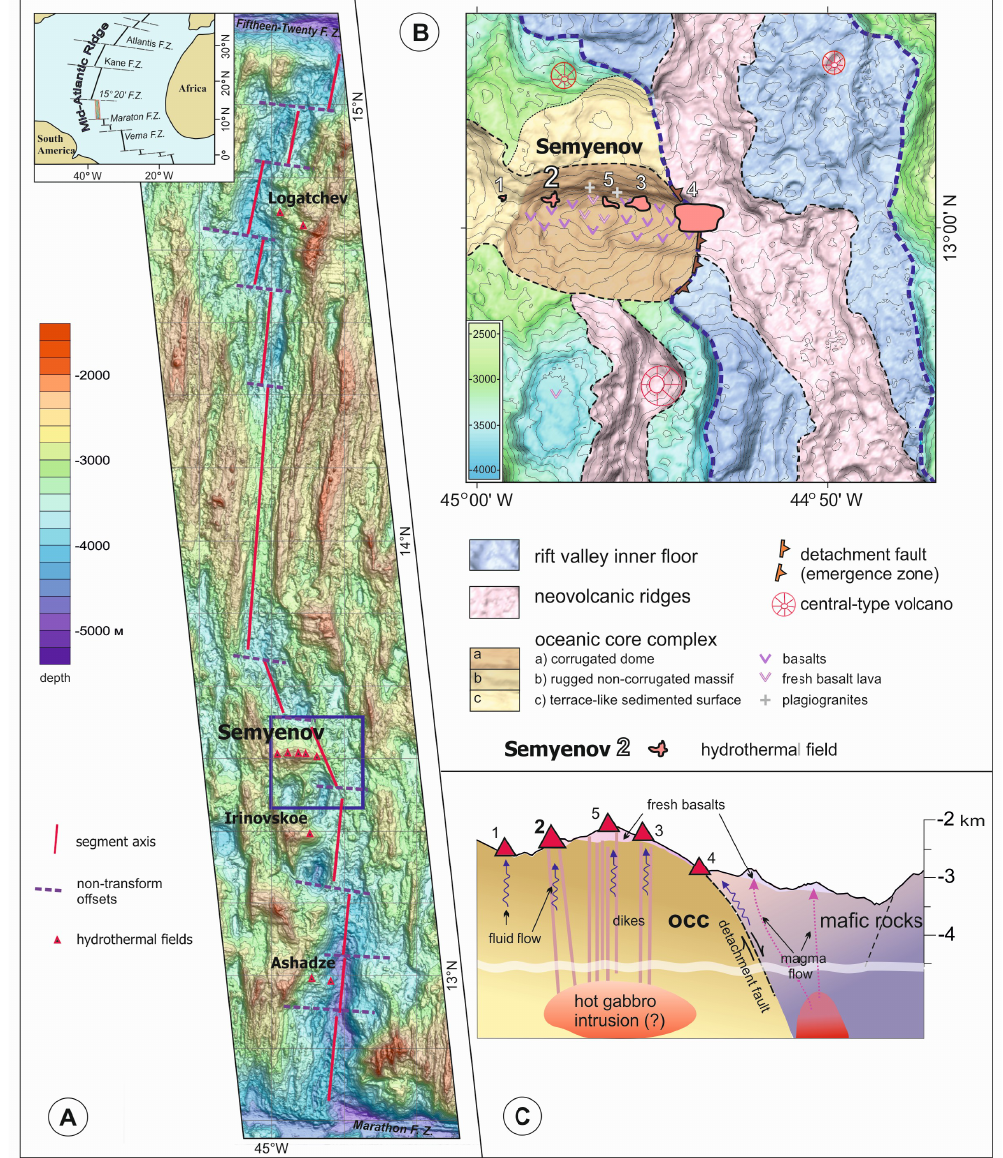
Figure 1. ( A ) Shaded-relief bathymetric map of the Mid-Atlantic Ridge between the Fifteen–Twenty Fracture Zone and the Marathon Fracture Zone, showing a second-order segmentation pattern and the location of the hydrothermal fields. The contour interval is 200 m. The box corresponds to the area of Figure 1B. ( B ) Morphostructural setting of the Semyenov hydrothermal fields. ( C ) Interpretative cross-section of the MAR rift valley in the Semyenov cluster (this figure was modified from Pertsev et al., 2012 [26]); vertical exaggeration